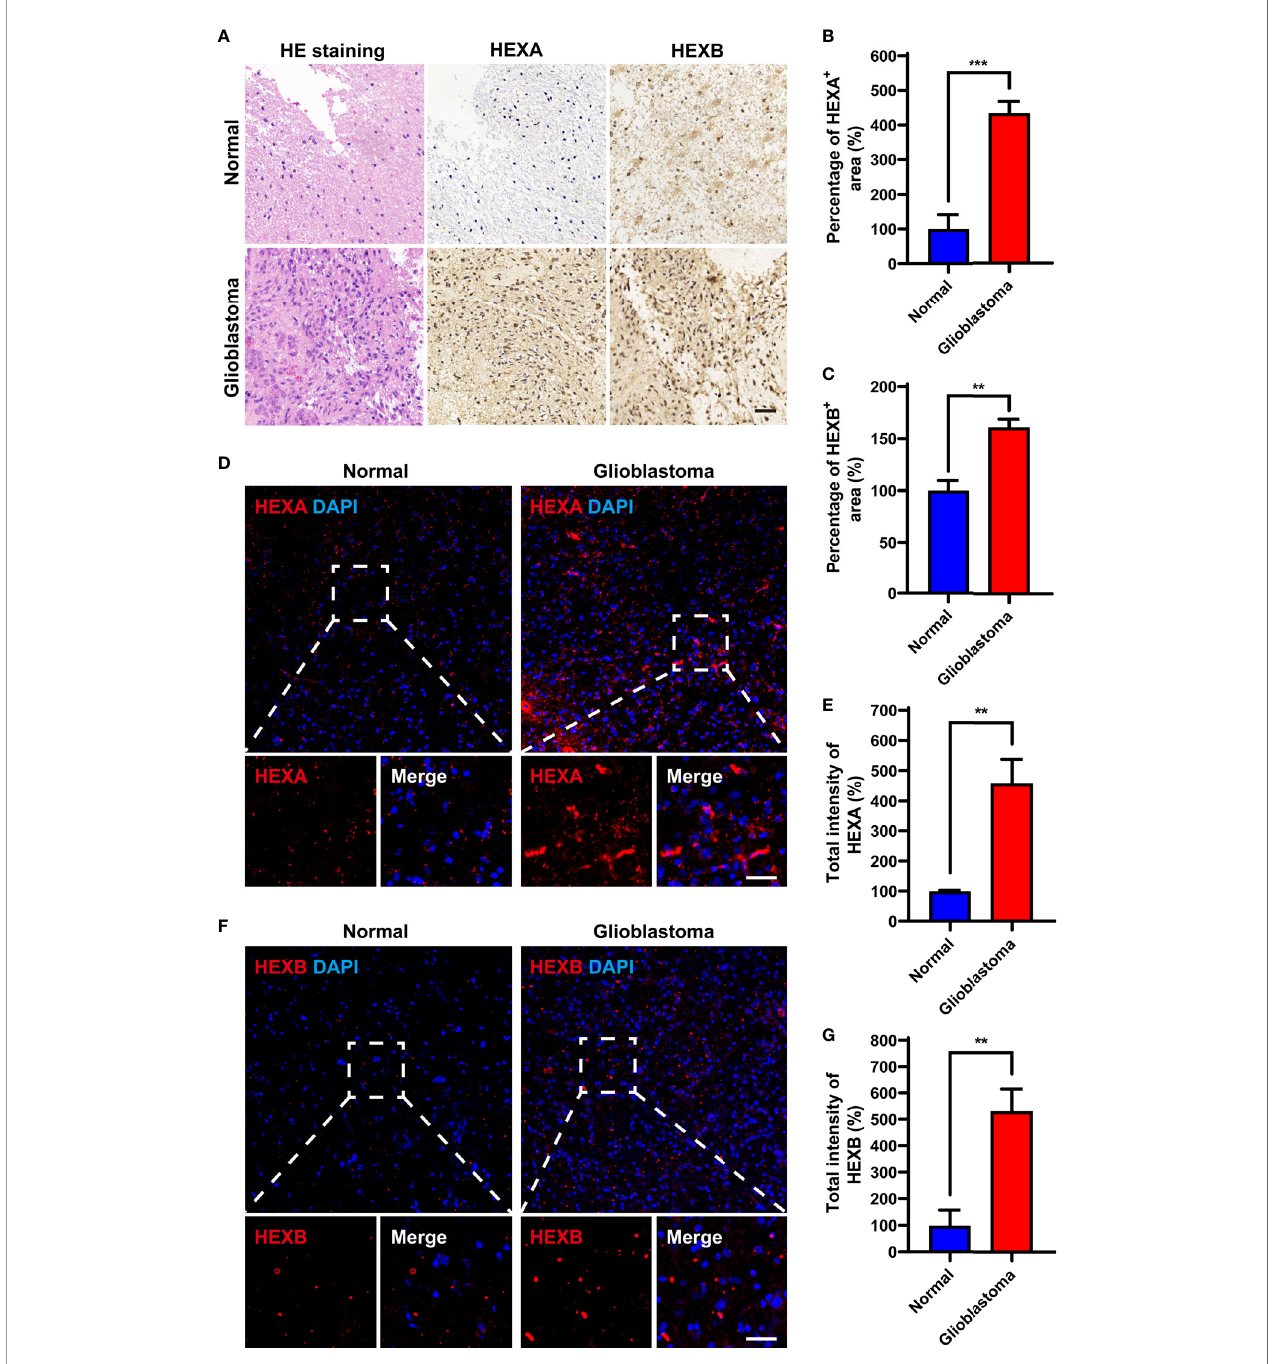
FIGURE 2 | Upregulation of HEXA and HEXB protein levels in GBM patient samples. (A) HE staining and immunohistochemistry staining of HEXA and HEXB in normal tissues and GBM tissues. (B, C) Quanti fi cation of the percentage of HEXA + and HEXB + areas in images presented in A (n = 3) (t-test, GBM vs Normal). (D) Immuno fl uorescence staining of HEXA in normal tissues and GBM tissues. (E) Quanti fi cation of the intensity of HEXA as shown in (D) (n = 3) (t-test, GBM vs Normal). (F) Immuno fl uorescence staining of HEXB in normal tissues and GBM tissues. (G) Quanti fi cation of the total intensity of HEXB as shown in F (n = 3) (t-test, GBM vs Normal). HE (hematoxylin and eosin), GBM (glioblastoma). Scale bars = 50 m m. Data are presented as the mean ± SD. ** p < 0.01, *** p <